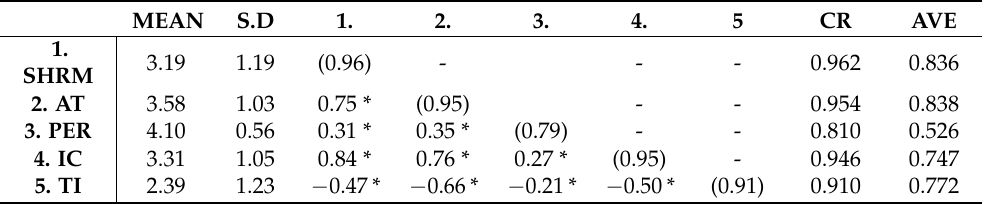
Table 1. Correlation